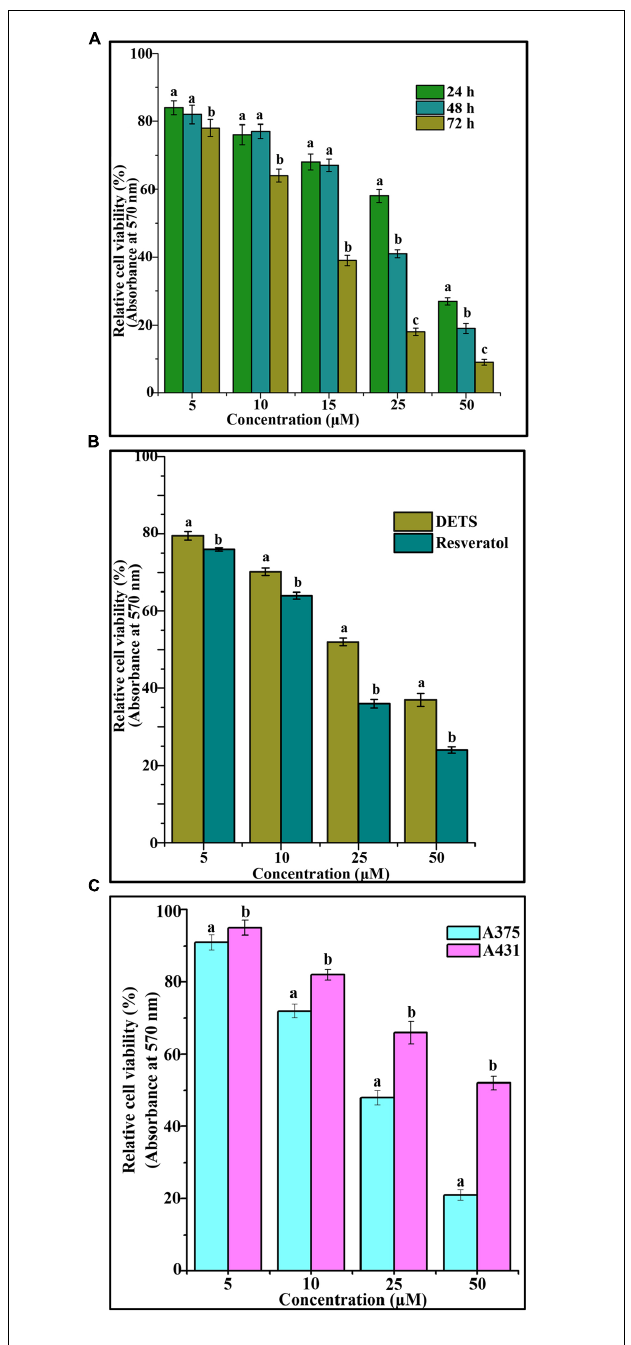
FIGURE 3 | DETS induces maximum cytotoxicity in melanoma cells. (A) Time dependent effect of DETS against human skin cancer cell, A375. (B) Comparison with resveratrol. All the measurements were done in three replicates and results are expressed as arithmetic mean ± standard error on the mean. (C) Comparison of the cytotoxicity of DETS in A375 (melanoma cell line) with that of a A431 (non-melanoma cell line). Cells were seeded in 96 wells and treated with indicated concentrations of DETS and resveratrol and subjected to MTT assay. All the measurements were done in three replicates and results are expressed as arithmetic mean ± standard error on the mean. Different letters in the superscript were significantly different according to Duncan’s multiple range test ( p <